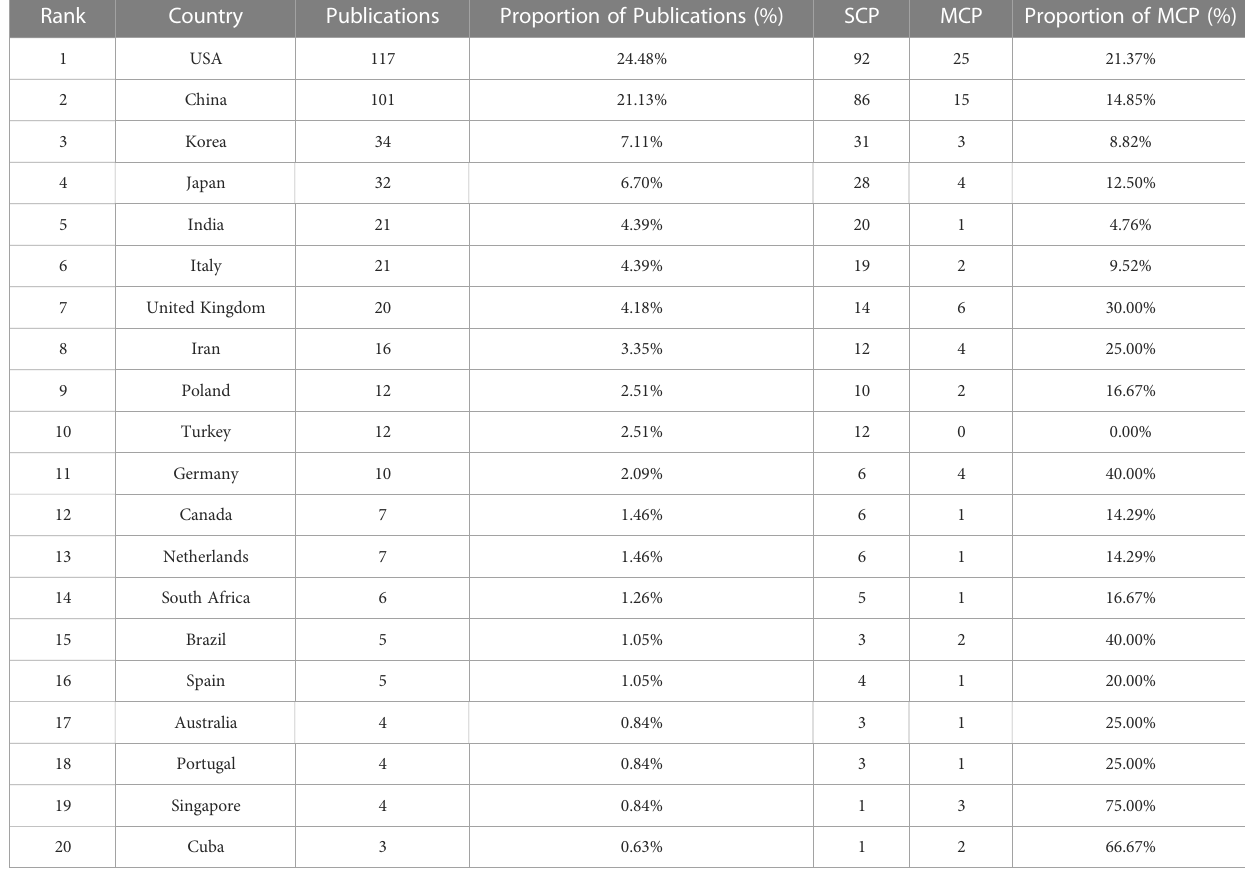
TABLE 1 Top 20 most productive countries/regions for fi broblast-related DFUs